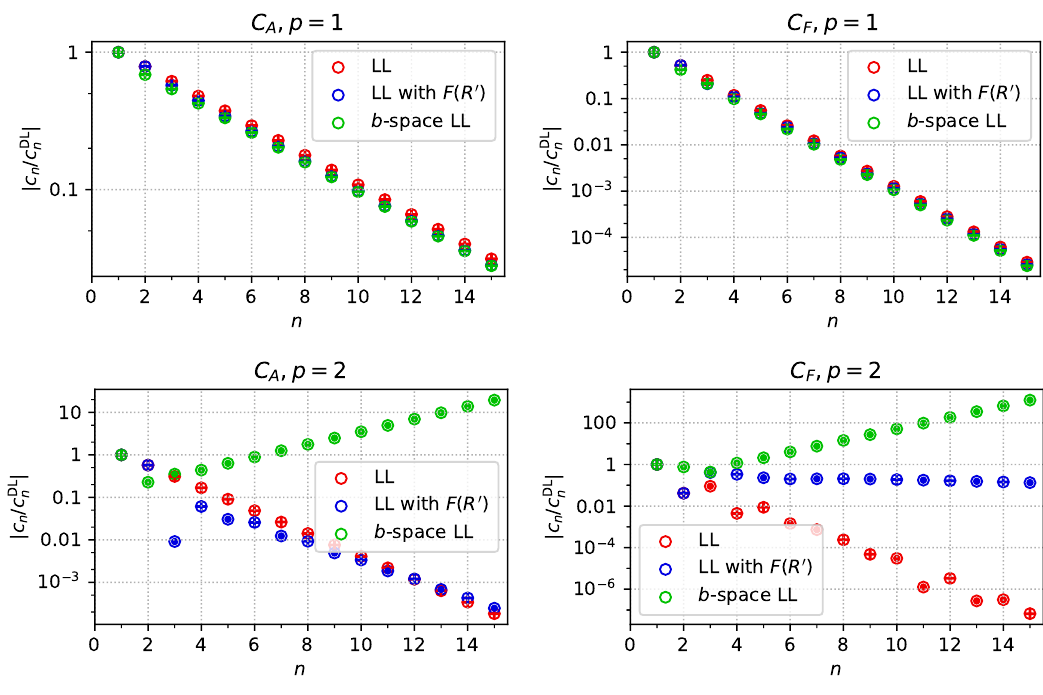
Figure 17 . The coefficients of the series expansions for δ p , eq. (C.5), using a variety of approxima- tion for Σ , eqs. (C.2)–(C.4), normalised to the coefficients from the DL series. The four plots show different combinations of colour factor and p . Circles with a central plus indicate a positive ratio, circles with a central dot indicate a negative